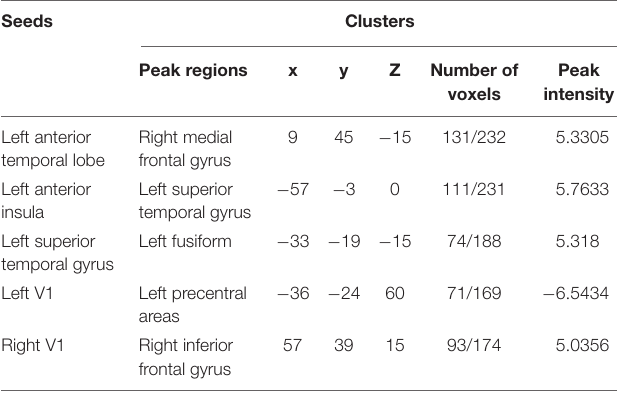
TABLE 2 | Regions of changed resting state functional connectivity in patients with PCA compared with healthy controls. Seeds